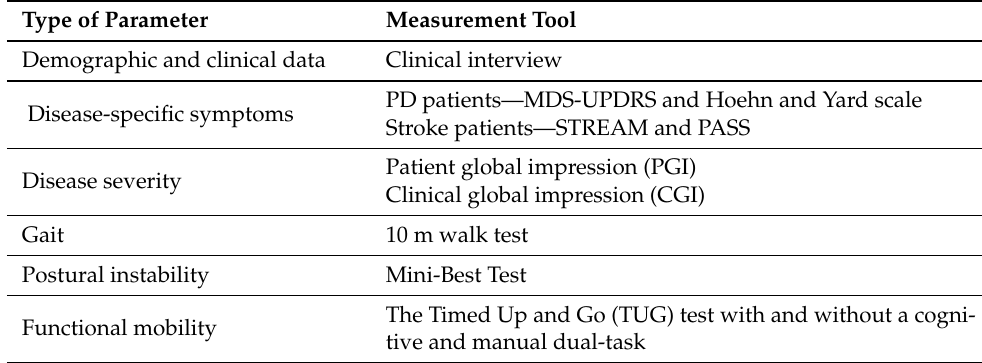
Table 1. Rundown of parameters